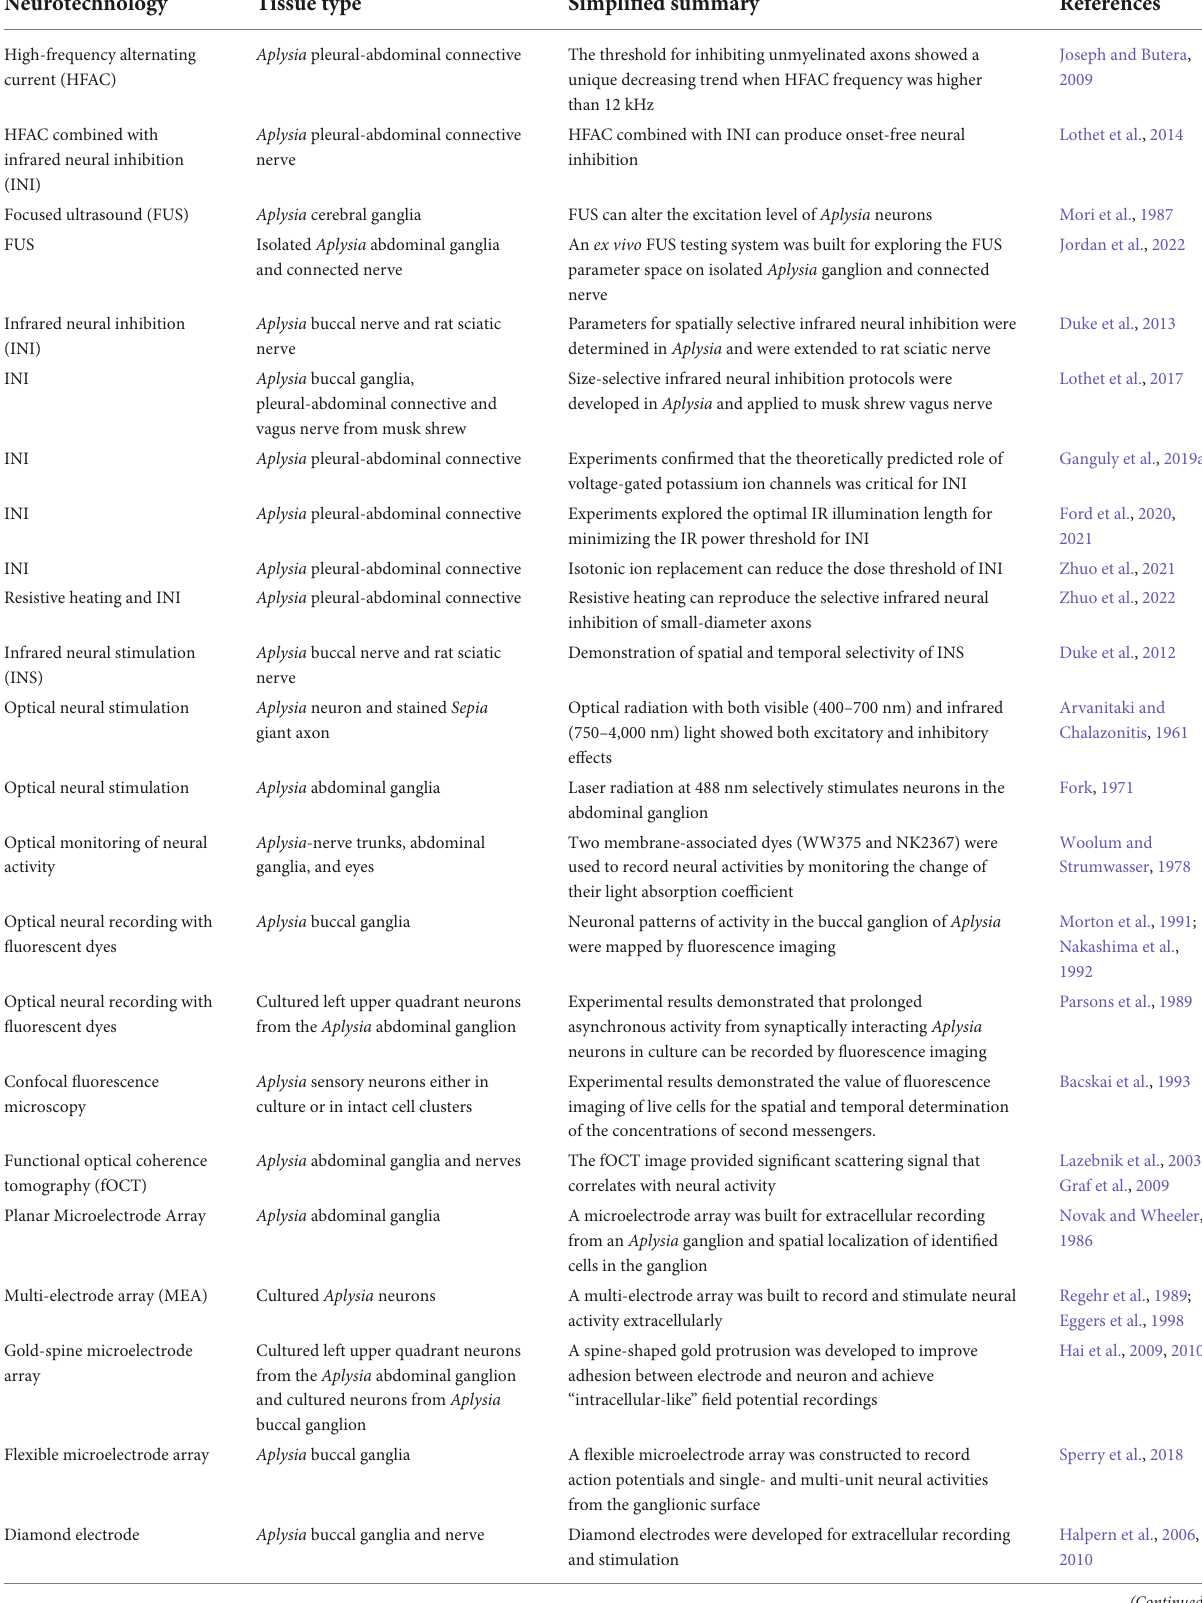
TABLE 1 Summary of examples using Aplysia in the development of neurotechnologies.